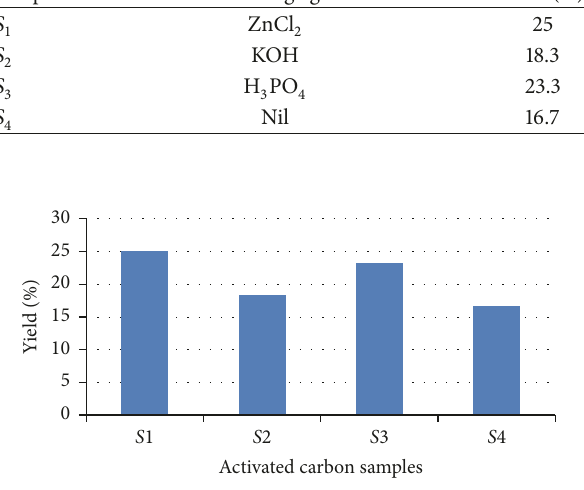
Figure 3: Chemical agent versus activated carbon